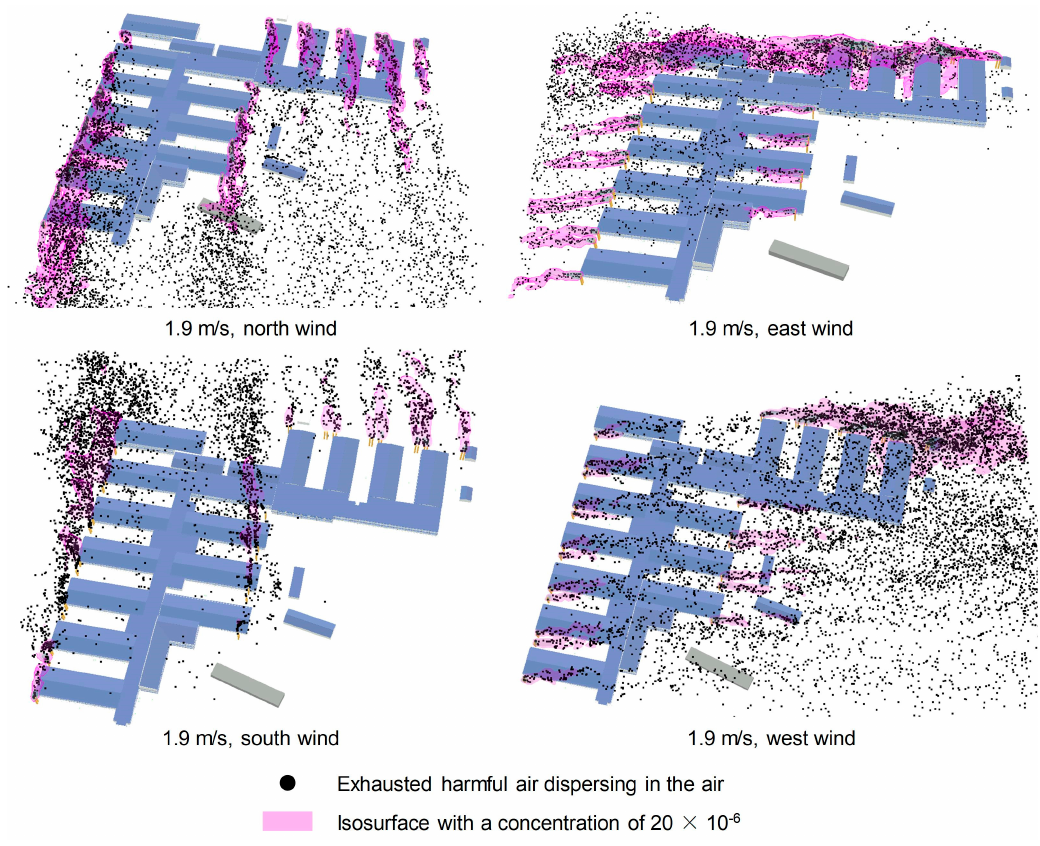
Figure 18. Visualizations of the exhausted harmful air from air outlets under di ff erent wind